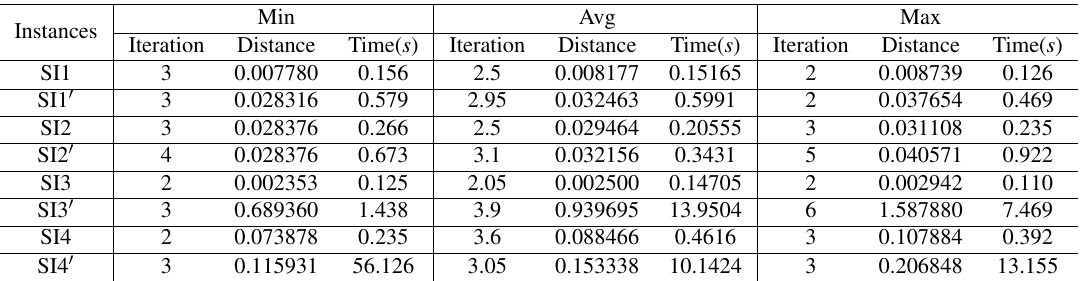
Table 4. The results of DA Algorithm Under Case